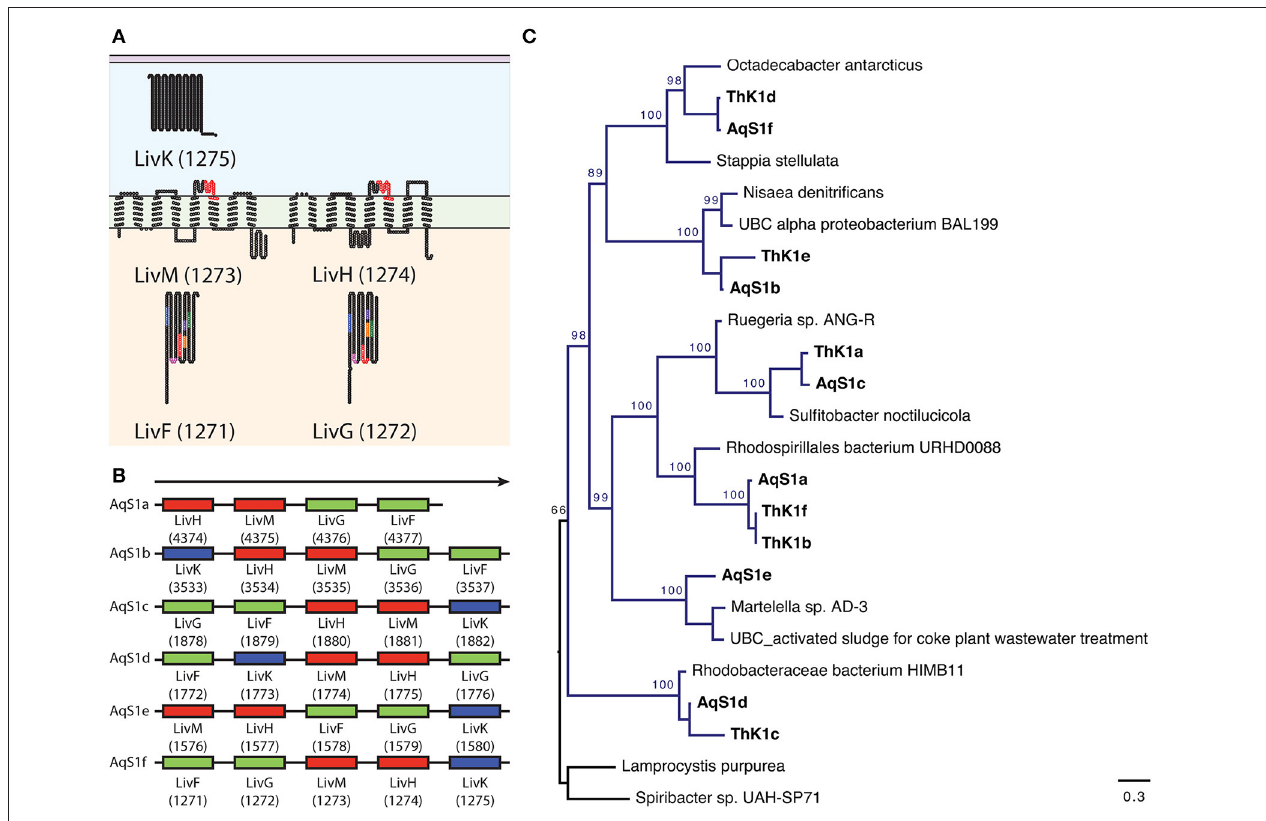
FIGURE 4 | Repertoire of high-affinity branched-chain amino acid ATP binding cassette (A,B,C) transporters present in AqS1 . The symbiont encodes multiple copies of the polycistronic LivFGHMK gene cassettes that are ATP-dependent high-affinity branched-chain amino acid transport systems involved in leucine metabolism and transport. (A) An example of putative 2D topology for one of the LivFGHMK transmembrane protein complex, derived using the program TOPO2. Conserved motifs are represented in different colors on the diagram. For LivF and LivG: blue AP-loop, pink Q-loop, red ATP transporter signature motif, orange Walker B-loop, purple D-loop, green, H-loop/switch region; For LivM and LivH: red TM-ABC transporter signature motif. The number in brackets corresponds to the RAST gene model id. (B) The AqS1 genome encodes six complete LivFGHMK gene cassettes; five of these cassettes are complete, while one – AqS1a – is missing a LivK homolog. Each cassette displays a different gene arrangement. (C) Maximum-likelihood phylogenetic tree for concatenated genes LivF, LivG, LivH, LivM, and LivK present within a polycistronic cassette for both AqS1 and T. sp. HK1 . We used two Chromatiales representatives as outgroup. All cassettes nested with different representatives of the class Alphaproteobacteria, within the orders Rhodobacterales and Rhodospirilales. Bootstrapping percentages greater than 50% are